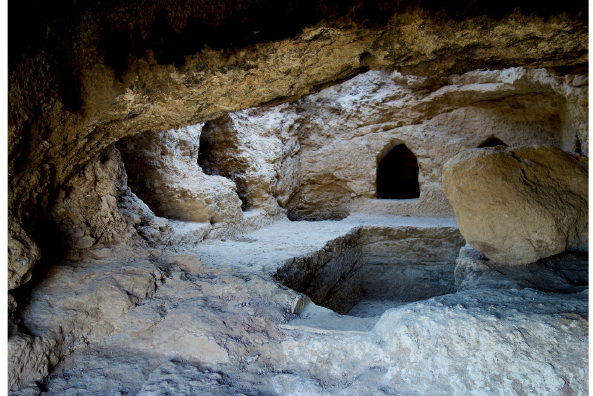
Figure 9. The burial